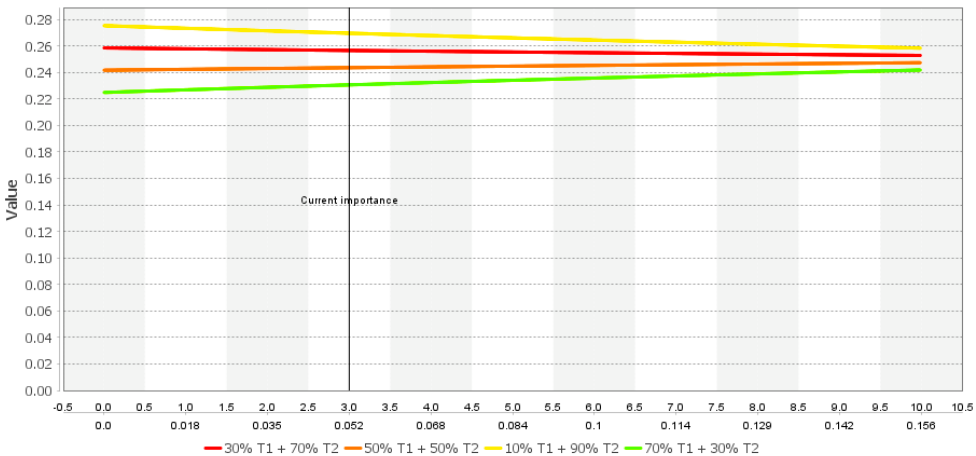
Figure 9. Effects of changing the weighting of the criterion “volatility” on the overall scores of the decision alternatives. The upper values of the x-axis are the absolute weights in the range 0 to 10. The lower values represent the relative normalized weights.